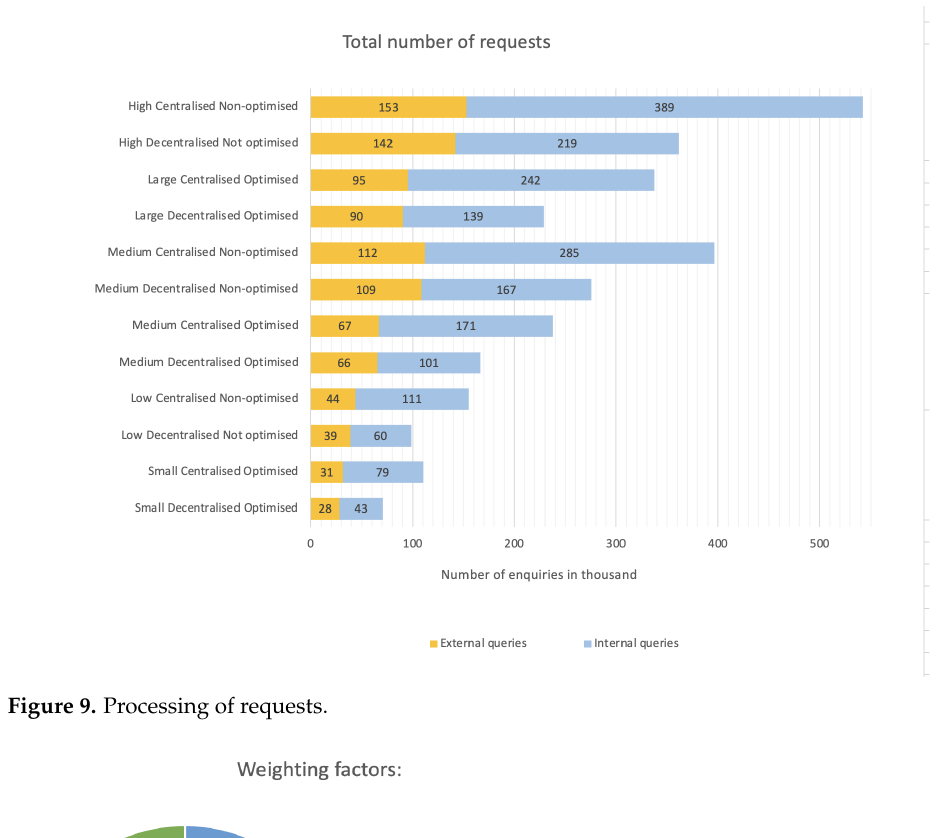
Figure 9. Processing of requests.